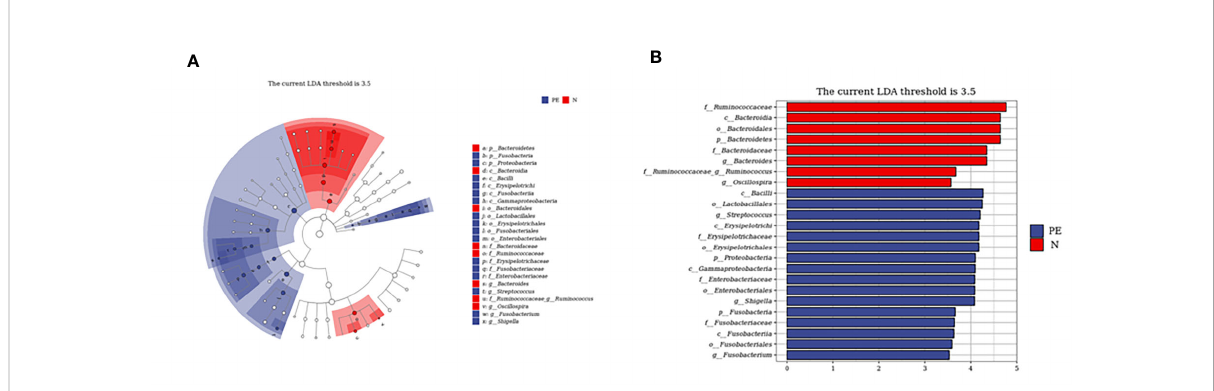
FIGURE 4 Taxonomic biomarkers of pregnant women between the two groups. Cladogram (A) and scores (B) of taxonomic biomarkers identi fi ed by LDA using LEfSe between the two groups. Color indicates the group in which a differentially abundant taxon is enriched. The LDA scores (log10) > 3.5. PE, preeclampsia; N, the healthy normal group; LEfSe, Linear discriminant analysis combined effect size measurements; LDA, Linear discriminant analysis; P, Phylum; C, Class; O, Order; F, Family; G, Genus.